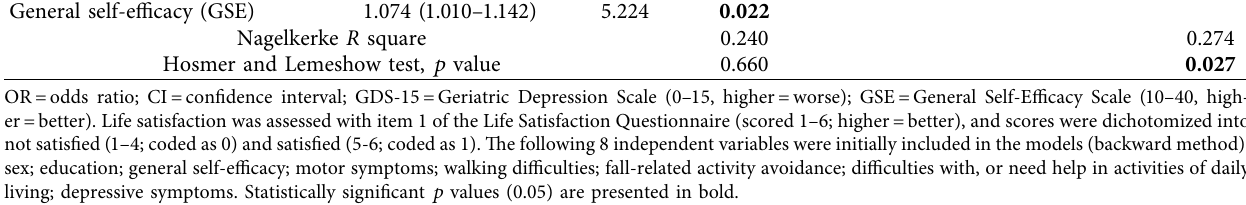
OR � odds ratio; CI � confidence interval; GDS-15 � Geriatric Depression Scale (0–15, higher � worse); GSE � General Self-Efficacy Scale (10–40, high- er � better). Life satisfaction was assessed with item 1 of the Life Satisfaction Questionnaire (scored 1–6; higher � better), and scores were dichotomized into not satisfied (1–4; coded as 0) and satisfied (5-6; coded as 1). The following 8 independent variables were initially included in the models (backward method): sex; education; general self-efficacy; motor symptoms; walking difficulties; fall-related activity avoidance; difficulties with, or need help in activities of daily living; depressive symptoms. Statistically significant p values (0.05) are presented in